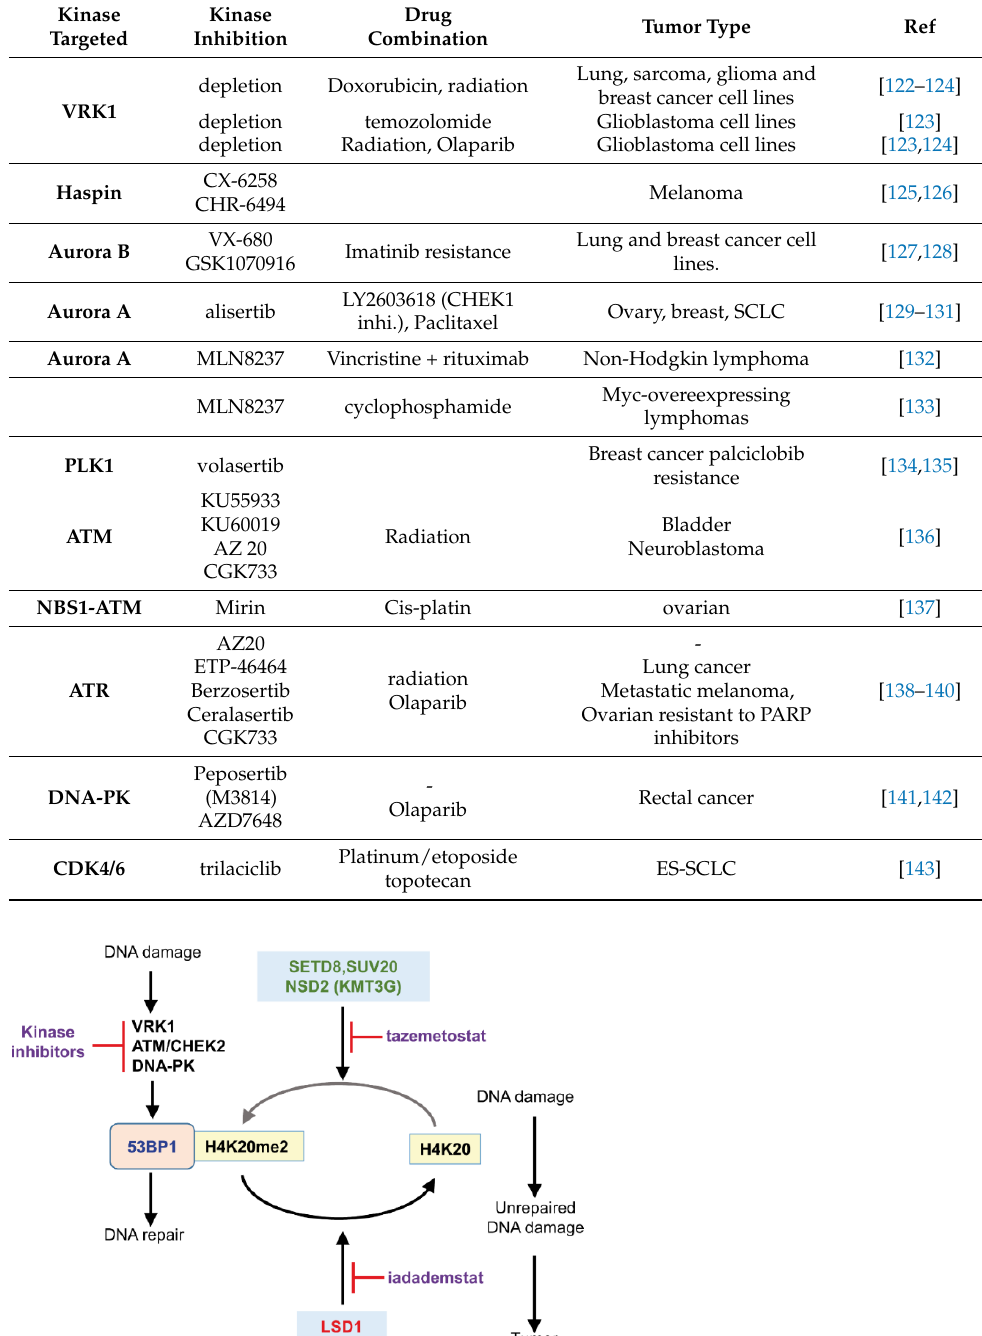
Table 3. Nuclear kinases that are druggable for synthetic lethality strategies.